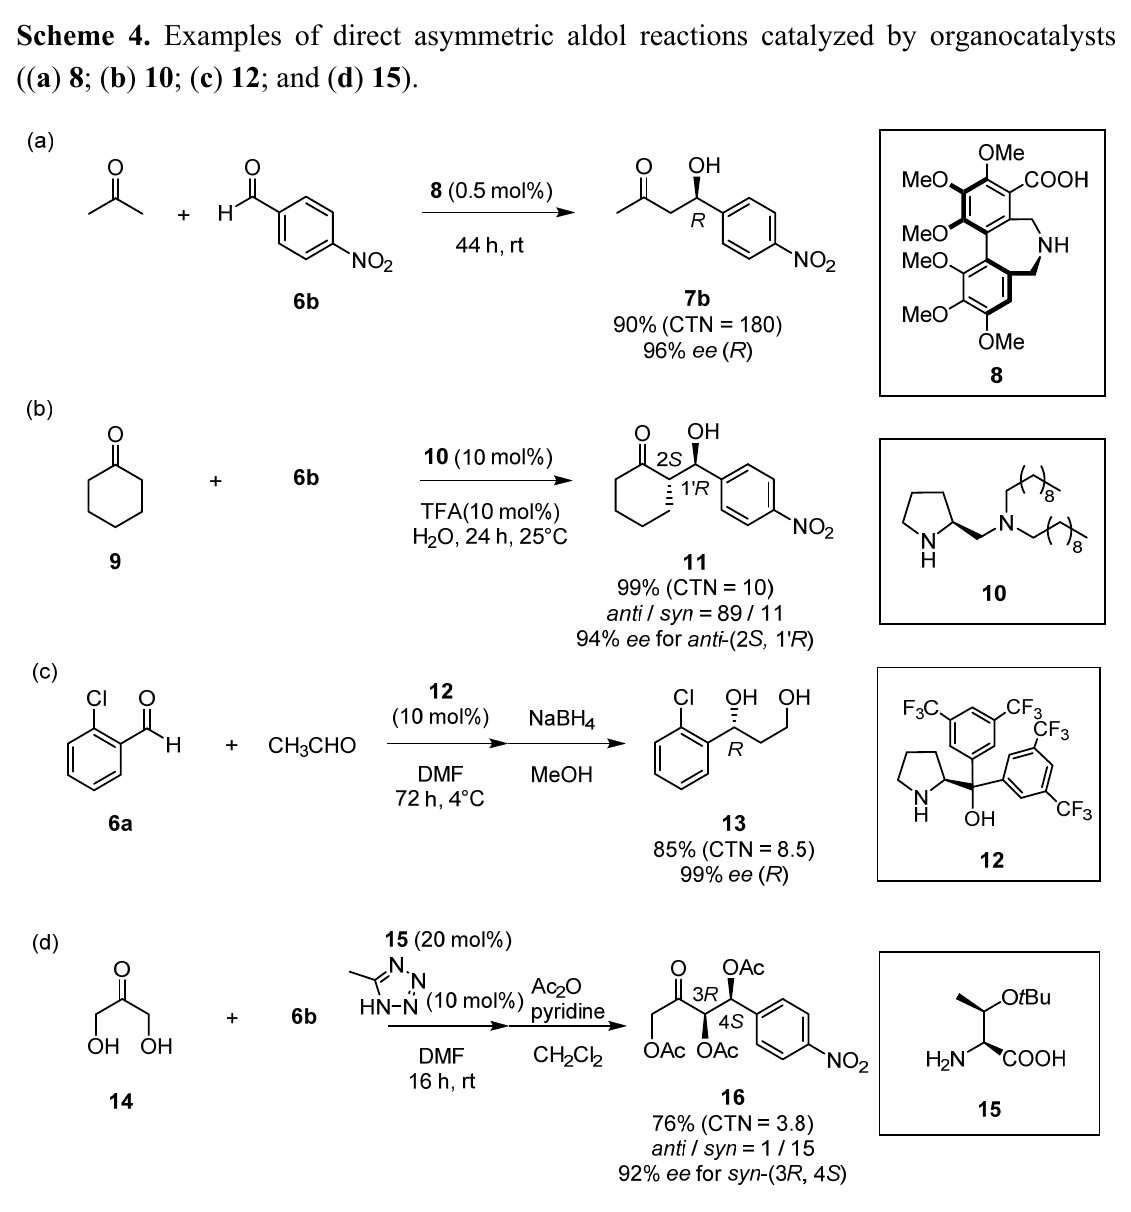
Scheme 4. Examples of direct asymmetric aldol reactions catalyzed by